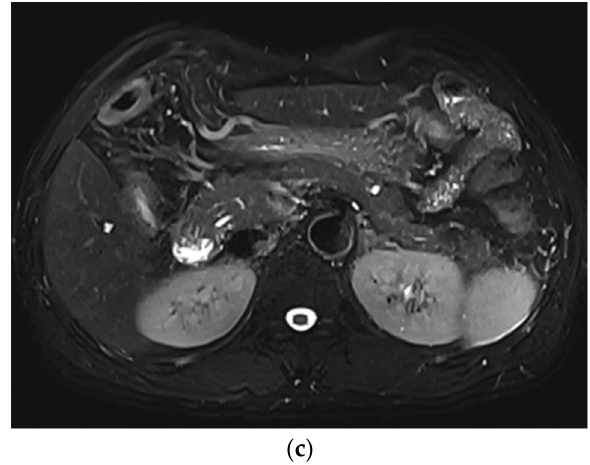
Figure 4. Comparison of conspicuity of main pancreatic cystic lesion (IPMN) in three T2WIs acquired on Vida. SSFSE CONV ( a ) was rated 4, mTSE ( b ) was rated 1, and SSFSE CS ( c ) was rated 5.